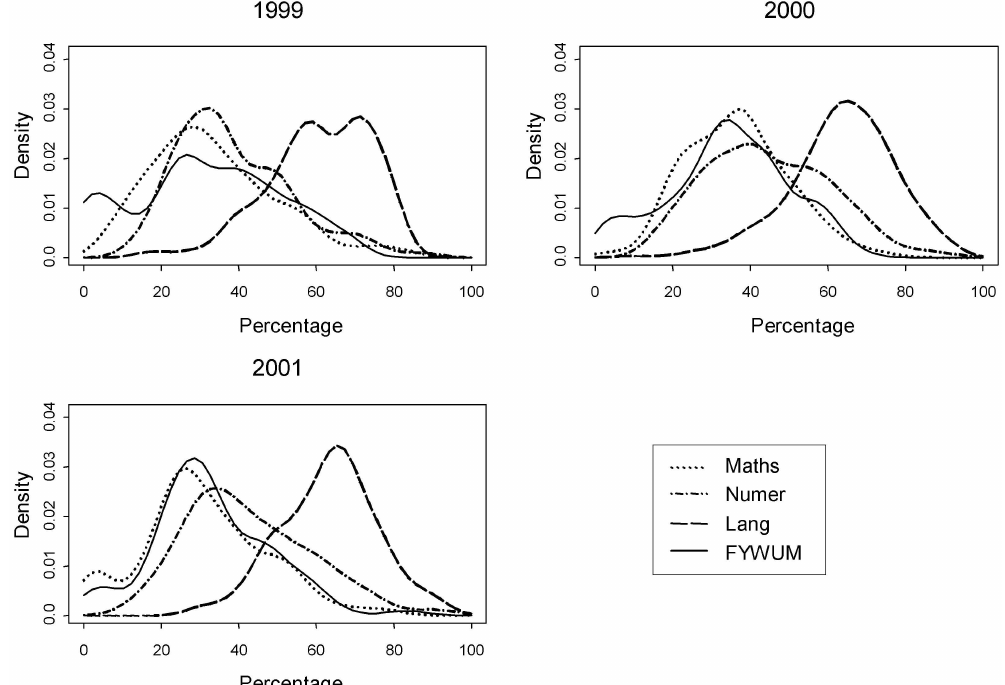
Figure 4: Kernel density estimates of the densities associated with the access test variables and the FYWUM of the Test Battery 2 data sets for 1999, 2000 and